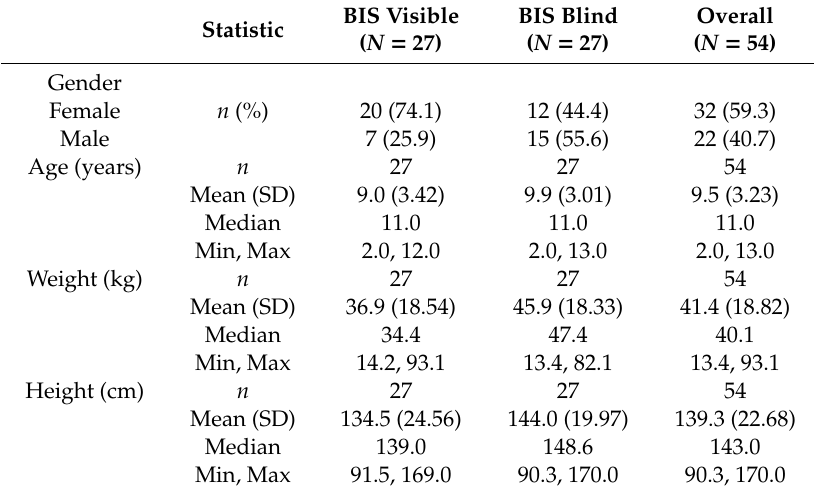
Table 2. Baseline